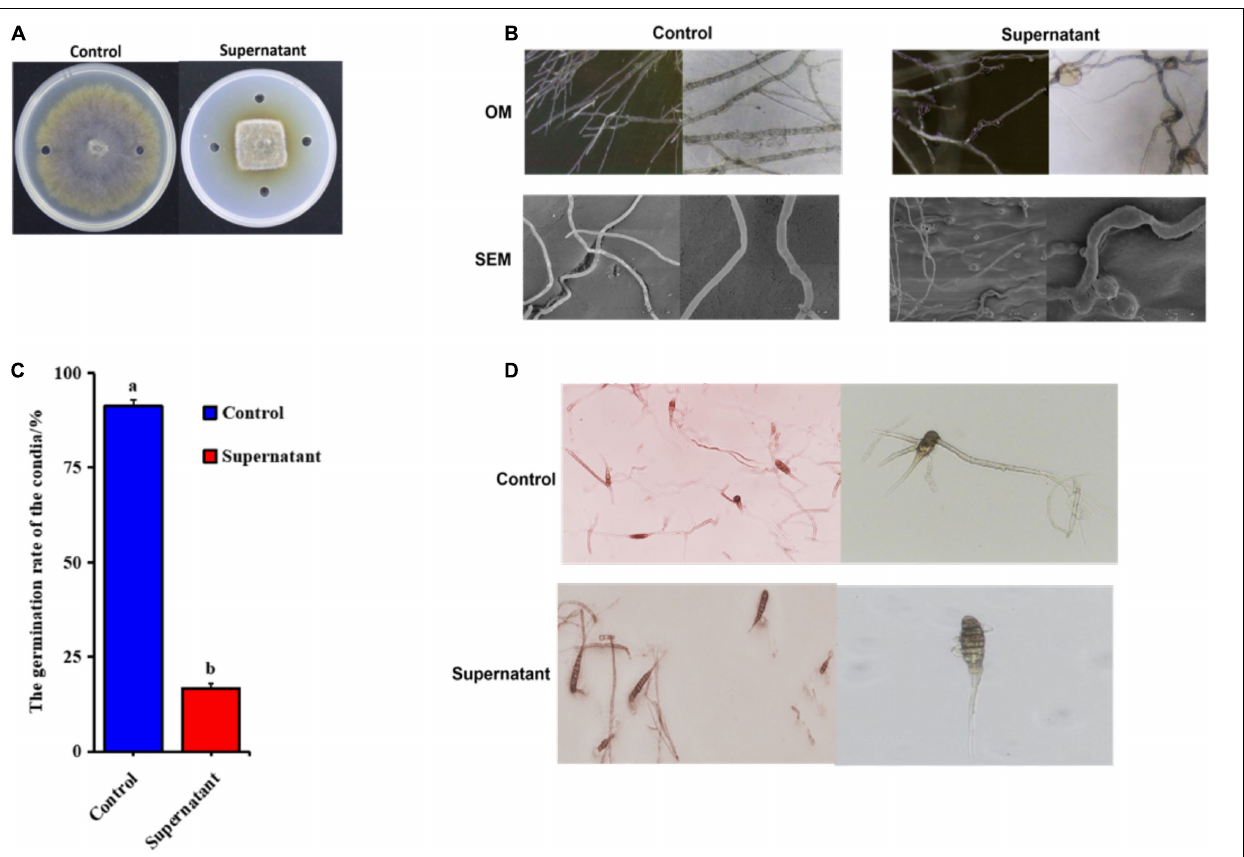
FIGURE 3 | Supernatant extracted from the ZD01 fermentation broth exhibited inhibitory effects on A. solani HWC-168 mycelial growth and conidial germination. (A) Effects of the supernatant produced by B. subtilis ZD01 on A. solani mycelial growth. (B) Optical and scanning electron micrographs of A. solani co-cultured with the ZD01 supernatant. (C,D) Reduction in conidial germination of A. solani treated with the ZD01 supernatant. Data are presented as means of three replicates ± SDs, and error bars represent the SDs for three replicates. Means with different letters are significantly different ( p <